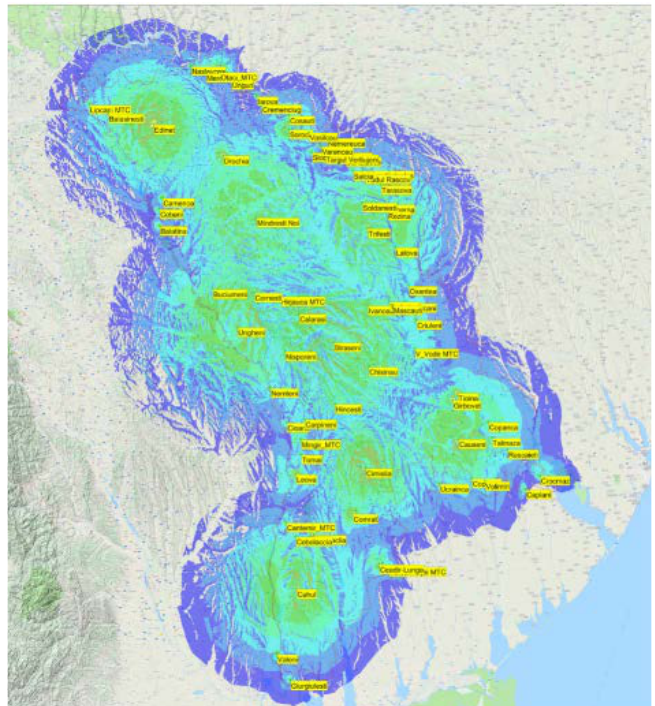
Figure 11. Mux-A coverage map after stopping analog television